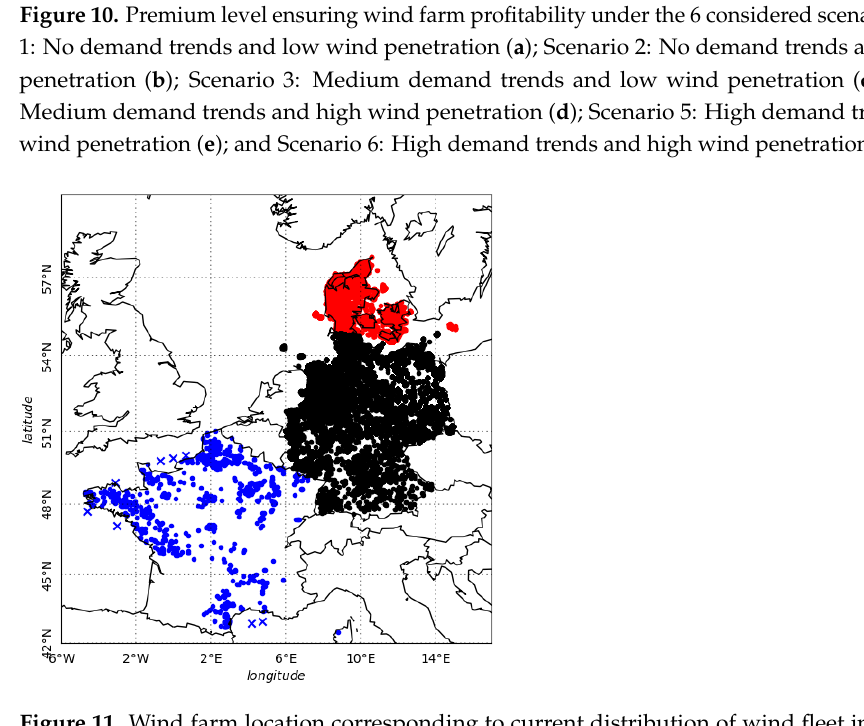
Figure 11. Wind farm location corresponding to current distribution of wind fleet in France (blue points), Germany (black points), and Denmark (red points). Blue cross markers indicate the location assumed for future offshore wind farms in